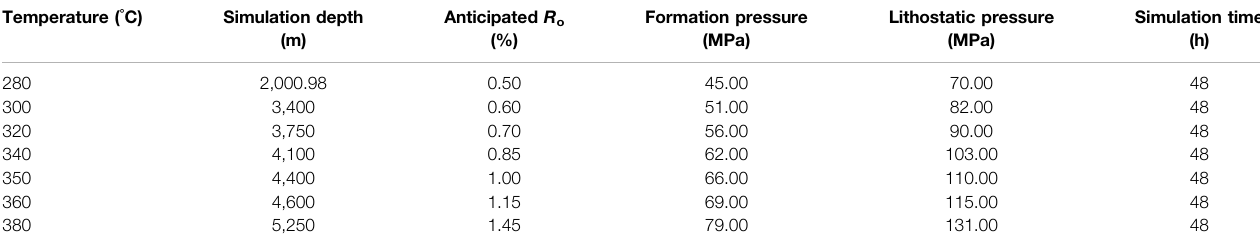
TABLE 2 | Experimental conditions of hydrocarbon generation and expulsion for stromatolite Temperature ( ° C)